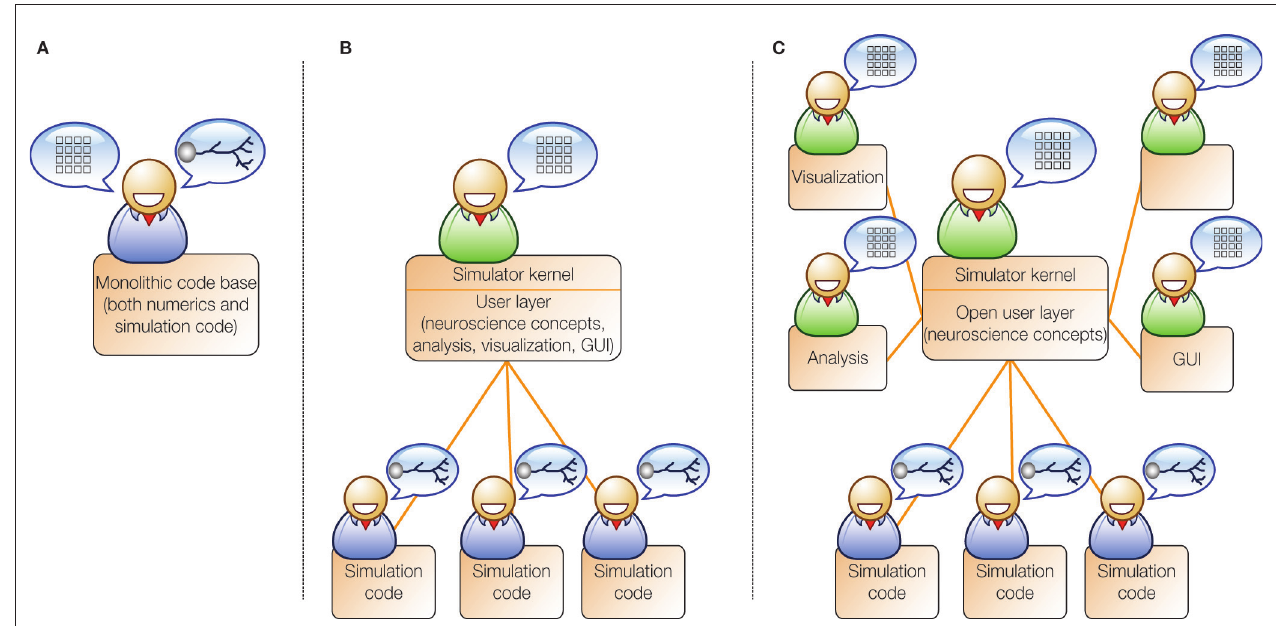
interpreted programming language. The simulator developers are able to concentrate on the domain-specific functionality, and to leverage tools for visualization, analysis, database access, network access, etc., developed by third-party developers external to neuroscience. The users benefit from greatly expanded functionality and easier extensibility of the simulator. The programmer icon was originally created by David Vignoni, and is reused here under the terms of the GNU Lesser General Public Licence (LGPL) (http://www.gnu.org/licenses/ lgpl.html). As a consequence, this image is also licensed under the LGPL. Copies of the image file are available on request from the corresponding